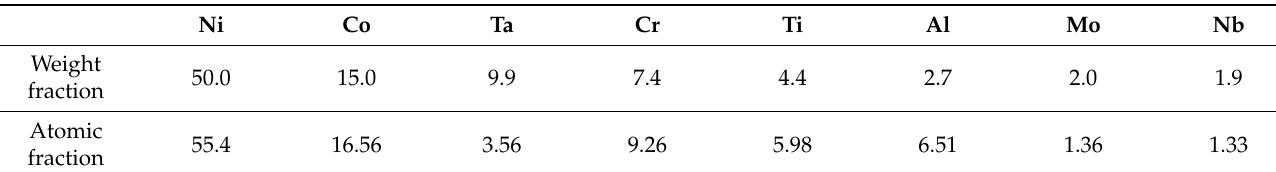
Figure 2. BSE images of microstructures ( a , d ) and SE images of γ’ morphologies ( b – f ) for SL ( a – c ) and SH ( d – f ) after heat treatment. and SH ( d – f ) after heat treatment. Table 2. Chemical composition of η phase. Table 2. Chemical composition of η phase.